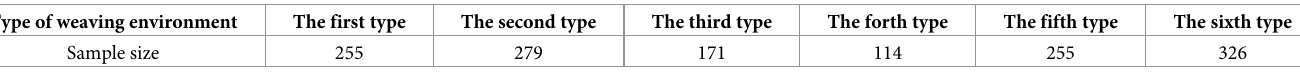
Table 1. Sample sizes of different types of weaving